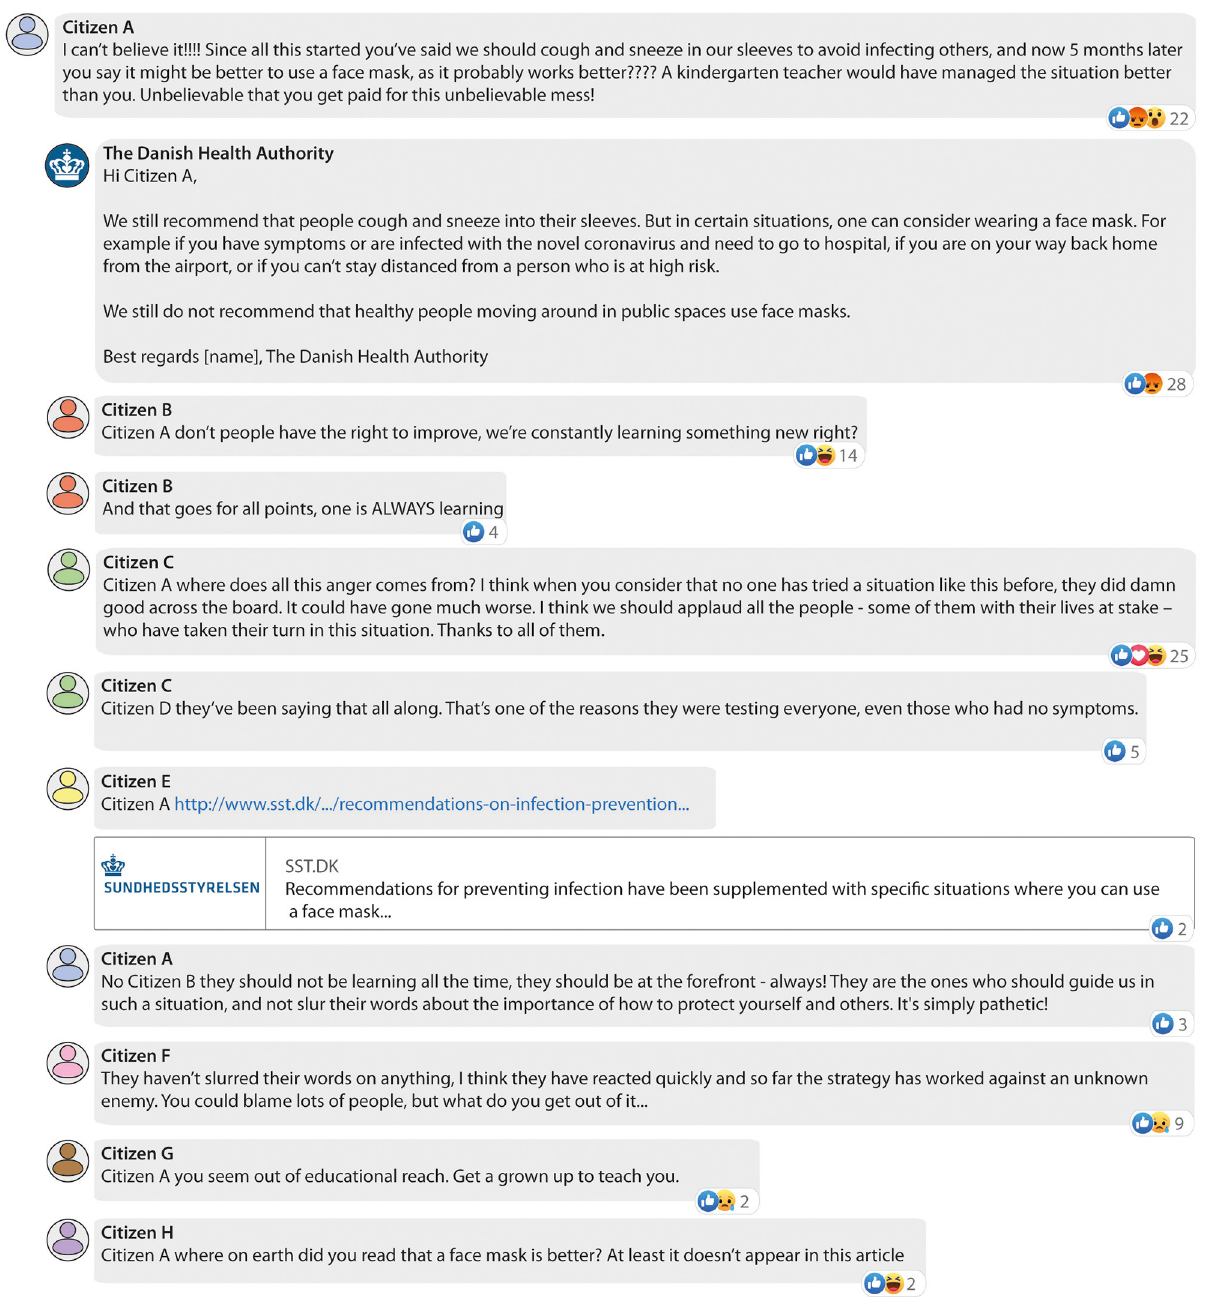
FIGURE 2 | Exemplar comment thread from the Danish Health Authority’s Facebook page. Reconstructed and translated into English. Please note, this figure is split across two pages.